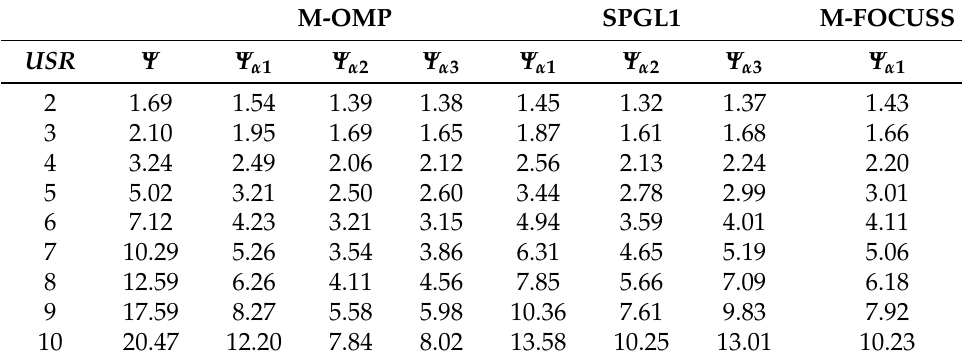
Table 2. Comparison of PRD values from the algorithms using the three dictionary matrices at several USR values, for ECG signal no. 105.